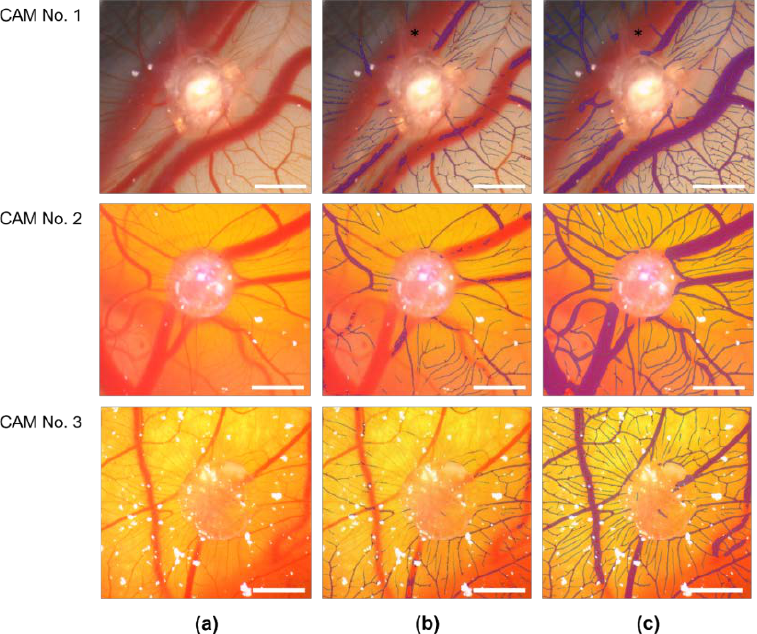
Figure 2. Visualization of the development of the CAM assay application with three different CAMs and engrafted AS-M cell line tumors (the white bar indicates 2 mm). ( a ) Original microscopic images of the CAMs with the grafted AS-M cell line tumor in the center. ( b ) Analysis of the microscopic images of CAMs with engrafted tumor cells with the CAM assay application v1.0.0 or ( c ) with the CAM assay application v3.0.0.